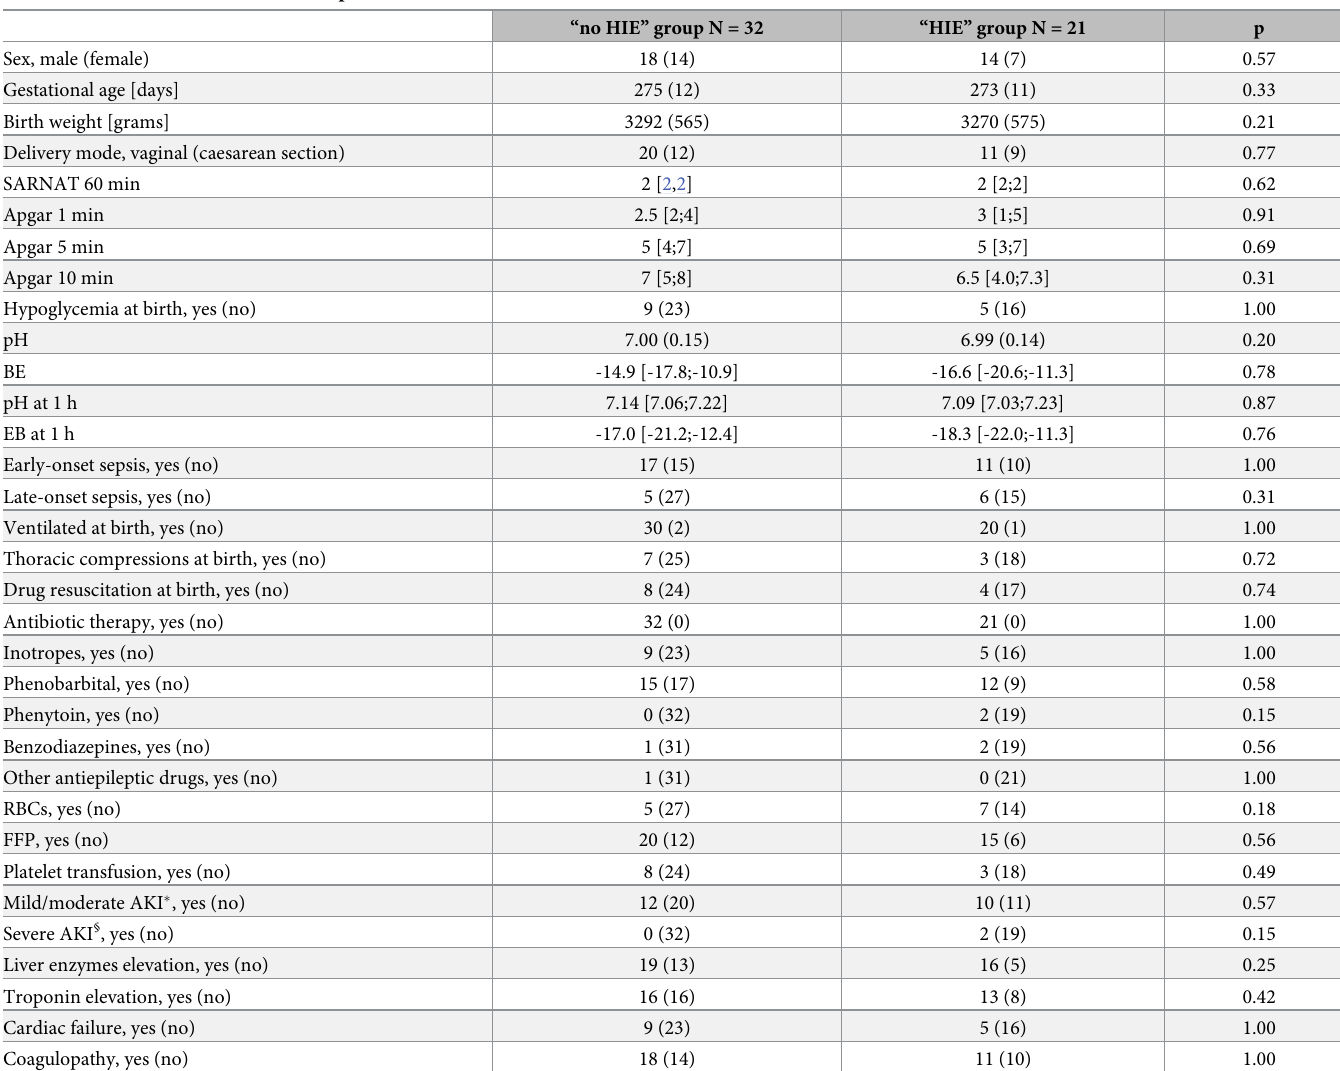
Table 1. Characteristics of the recruited